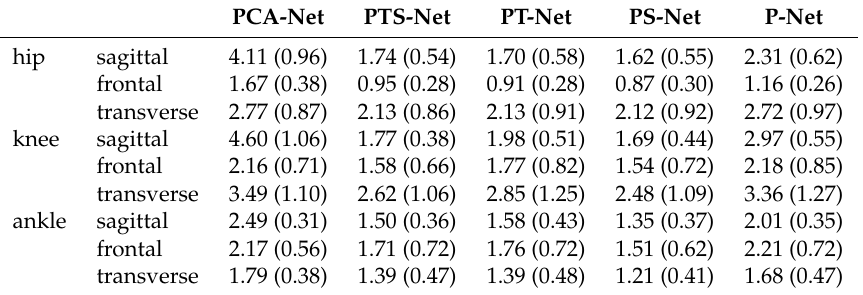
Table 3. Mean (standard deviation) of the RMSE for the five-fold cross-validation using the different input parameters. The joint angles predicted for the left and right have been